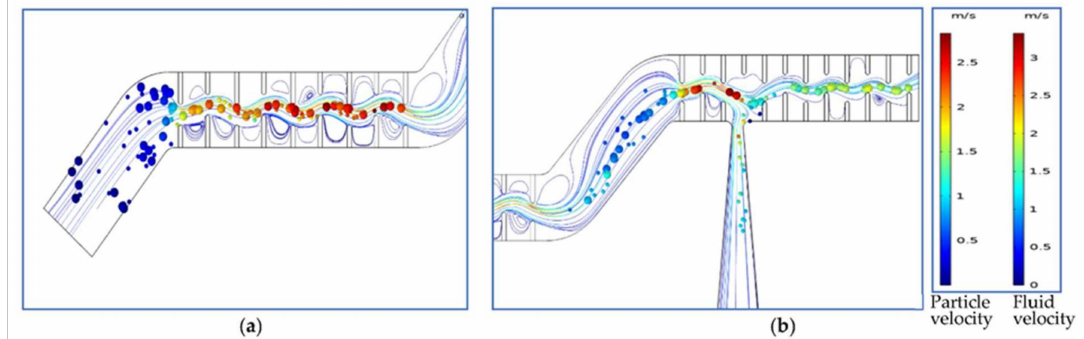
Figure 8. Particles traveling in cilia wall microchip at: ( a ) 1st microchannel with cilia walls at time